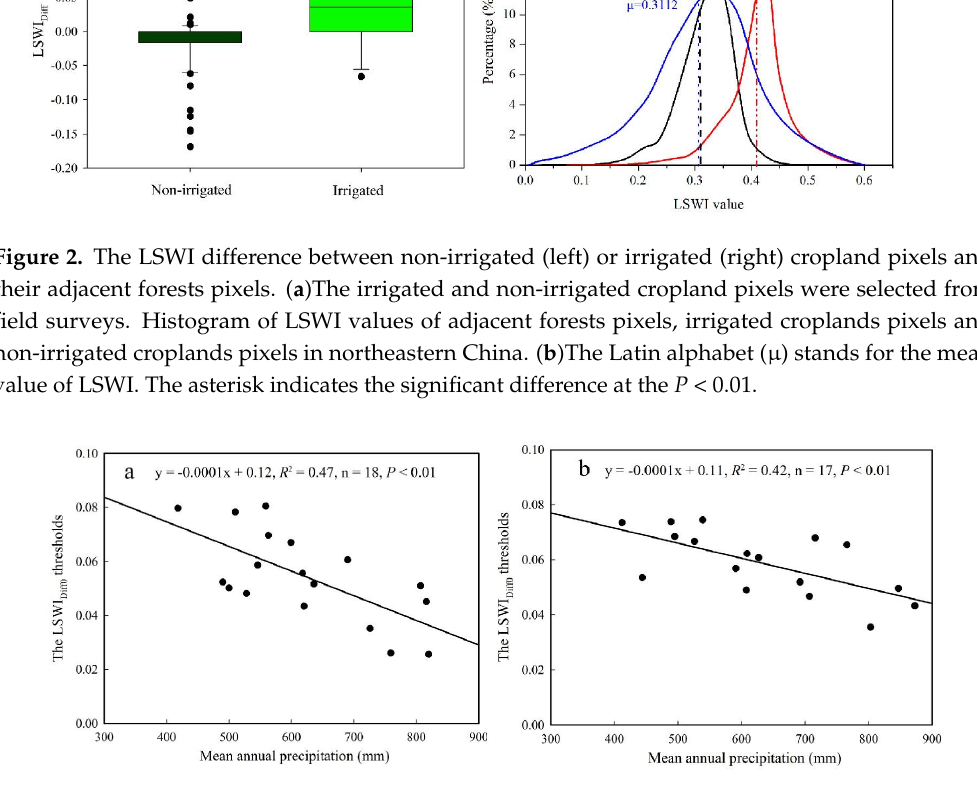
Figure 3. The linear regression relationship between the ( a ) half of the area prefectures, ( b ) other half of the area prefectures LSWI Diff0 thresholds and the mean annual precipitation at the prefecture level in northeastern China.